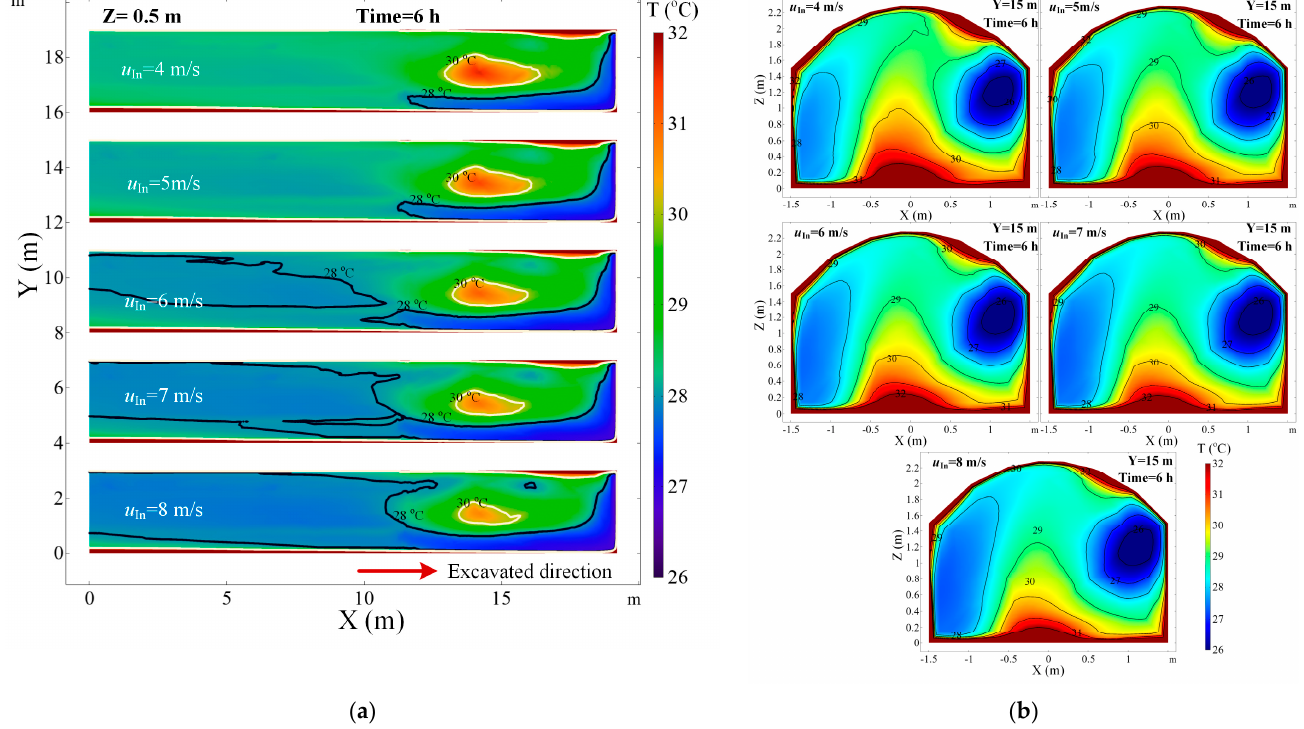
Figure 6. Air temperature distribution in roadway under different ventilation velocity: ( a ) air temperature in the Z = 0.5 m plane; ( b ) air temperature in the Y = 15 m section.